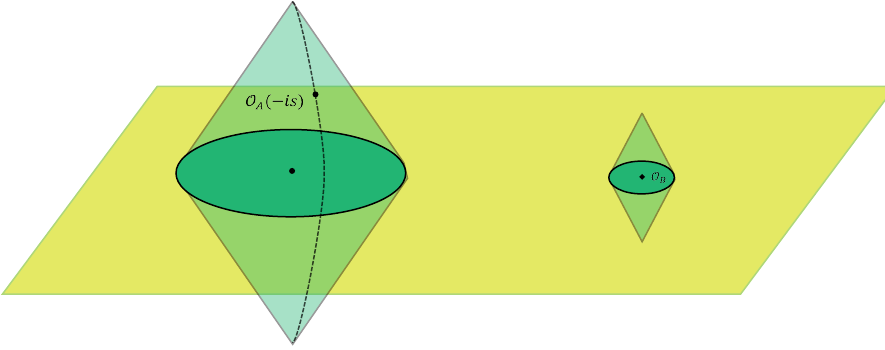
Figure 4 . The locations for O A ( − is ) and O B . In the limit of large separation, the modular trajectory of O ( − is ) almost passes through the center of A A